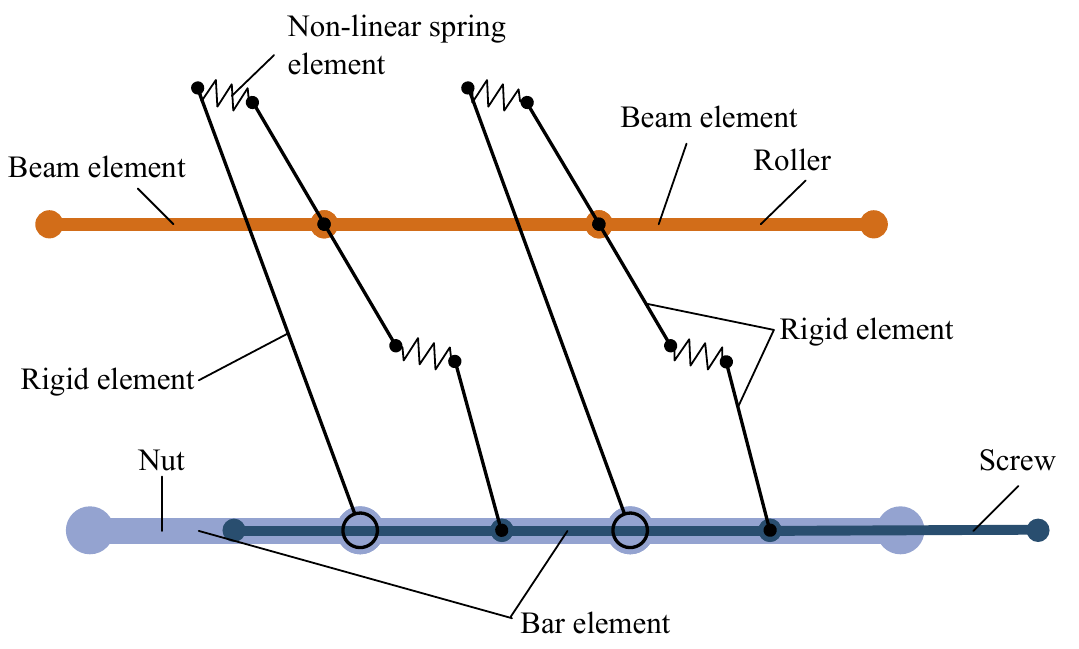
Figure 9. Discrete model of the inverted PRSM in Ref. [21].